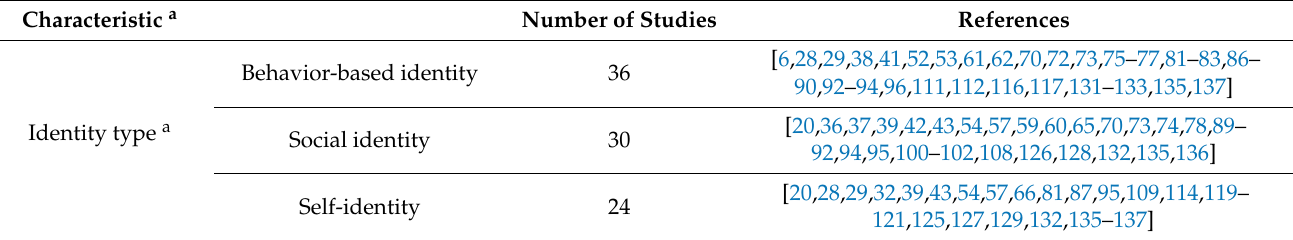
Table 2. Operationalization of identity ( n =